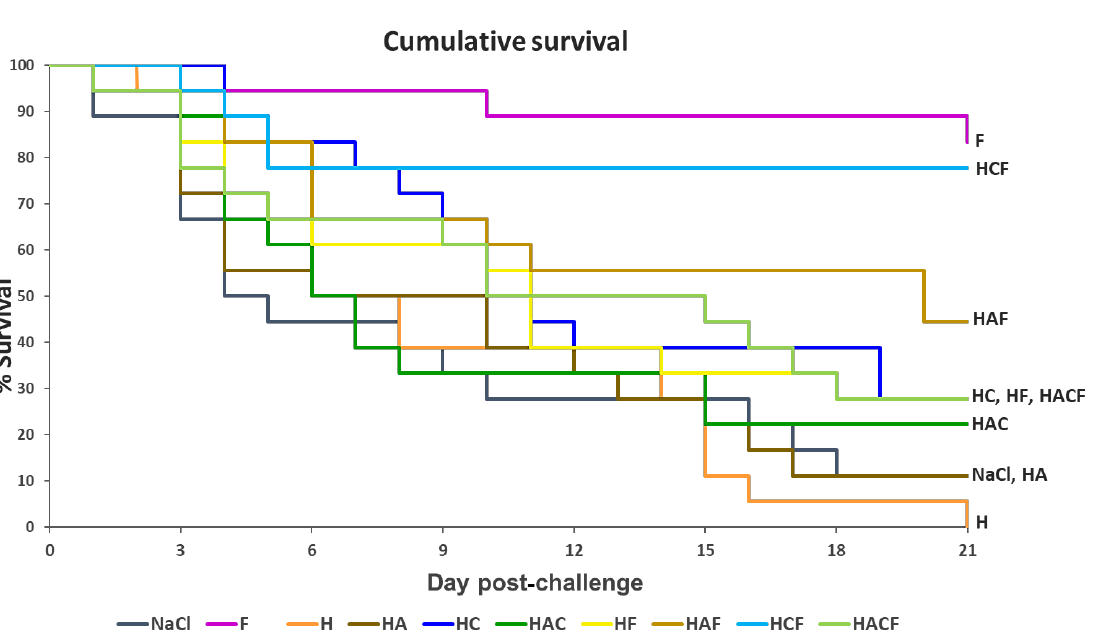
Figure 5. The Kaplan–Meier graph representing the cumulative survival of tilapia ( Oreochromis sp.) after being challenged with S. agalactiae serotype III at 1 × 10 8 CFU.mL − 1 for three weeks. The %RPS of all vaccinated groups were compared with the injected StrepKU-1 vaccine (81.25 ± 0.00%). Importantly, the %RPS of HCF (75.00 ± 10.83%) showed no significant difference with the injected StrepKU-1 vaccine. This observation was different from other StrepKU-1-loaded HNTs, in which the %RPS of the HF and HACF groups showed the same level of %RPS (18.75 ± 10.83%), whereas the HAF group was 37.50 ± 10.83%, and all of them showed significantly lower %RPS compared with the injected StrepKU-1 vaccine and the HCF-administered group (Figure 6).